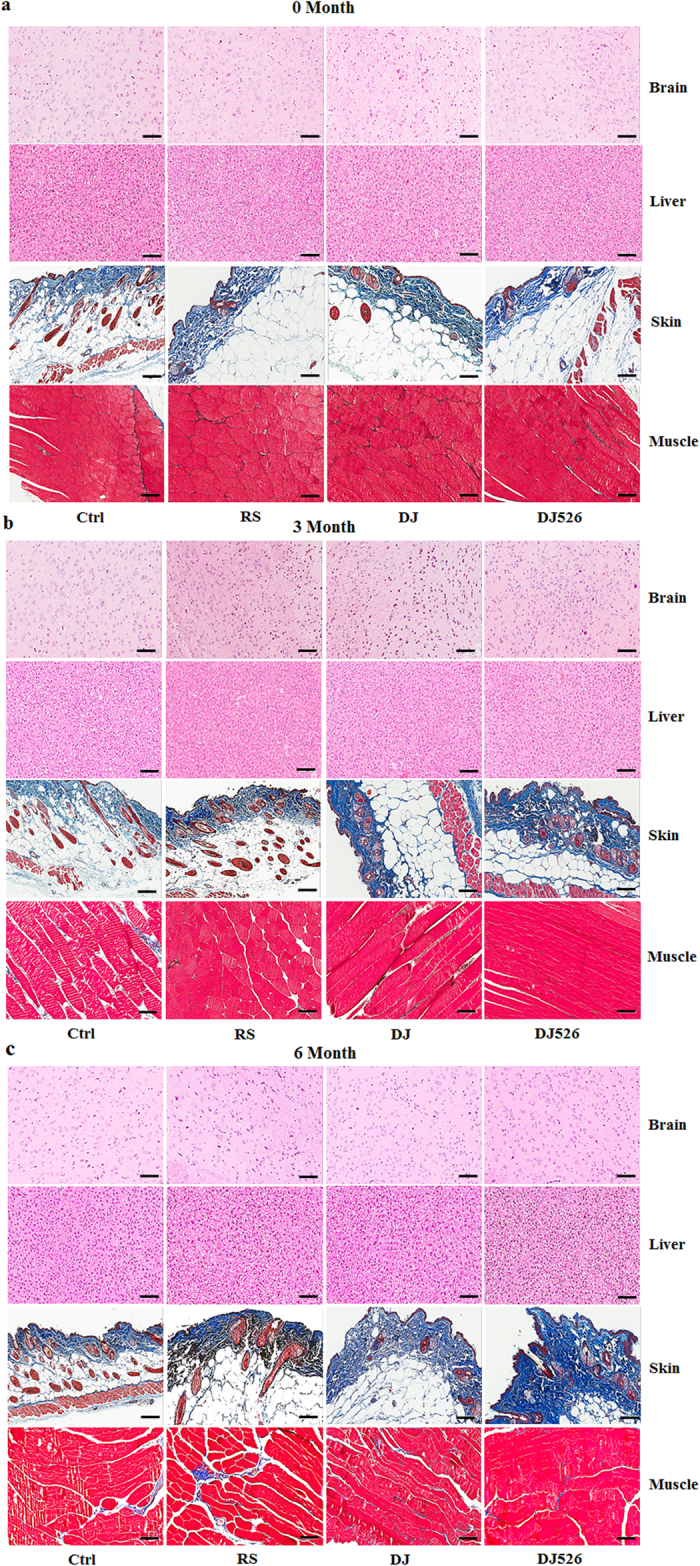
The effects of the resveratrol-enriched rice DJ526 in organs with age-progression.The control (Ctrl) mice fed a NFD in which the carbohydrate source was corn starch and sucrose; The resveratrol (RS) mice fed a NFD in which the carbohydrate source was corn starch and sucrose except containing resveratrol; Dongjin (DJ) mice fed a NFD in which the corn starch and sucrose were replaced with Dongjin rice; DJ526, mice fed a NFD in which the corn starch and sucrose were replaced with the resveratrol enriched rice DJ526. The resveratrol concentration in DJ526 and RS groups was 0.69 μg/g each, and not detected in Ctrl and DJ groups. Brain and liver histology images with H&E stain. Skin and muscle histology images with MT stain. Representative images of each organ from four experimental groups at 0 month (a), 3 month (b) and 6 month (c). Scale bars, 100 μm in all the images.